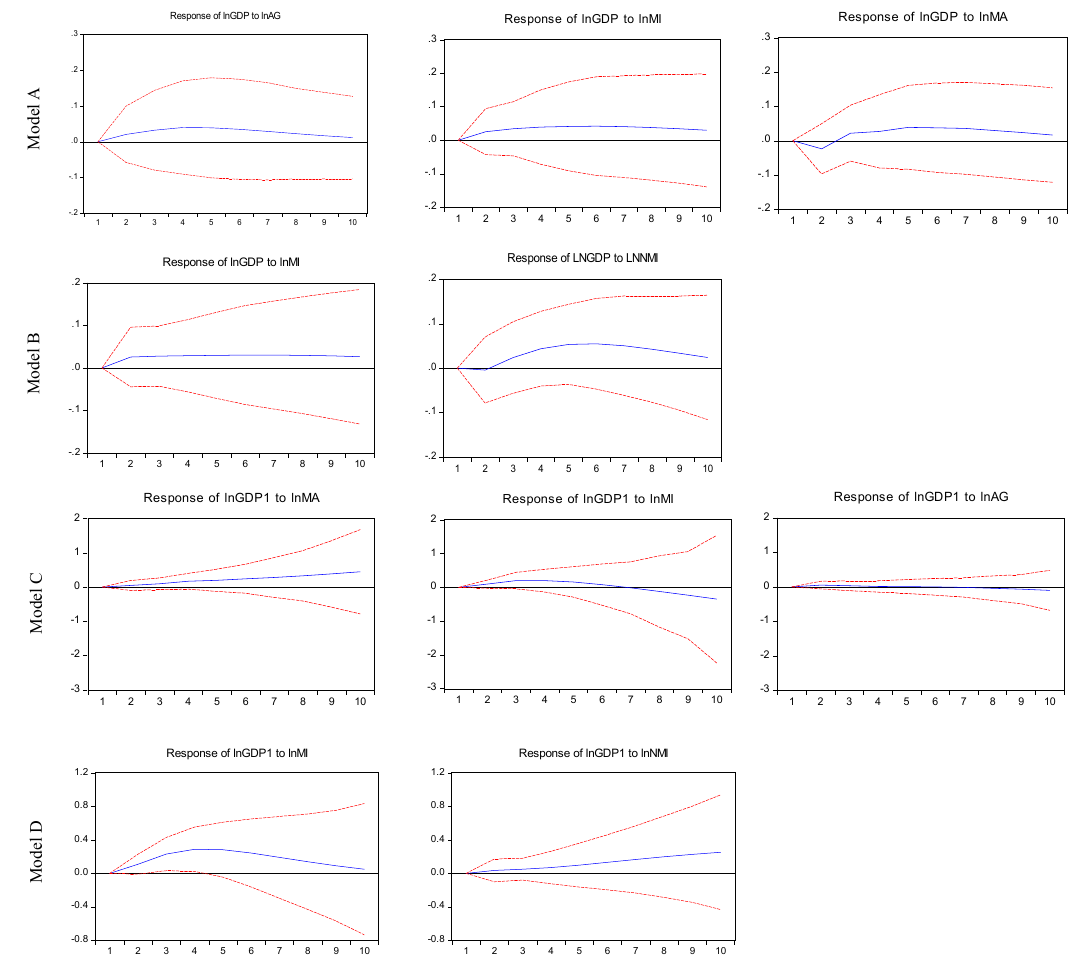
Figure 3. Impulse response function (IRF).